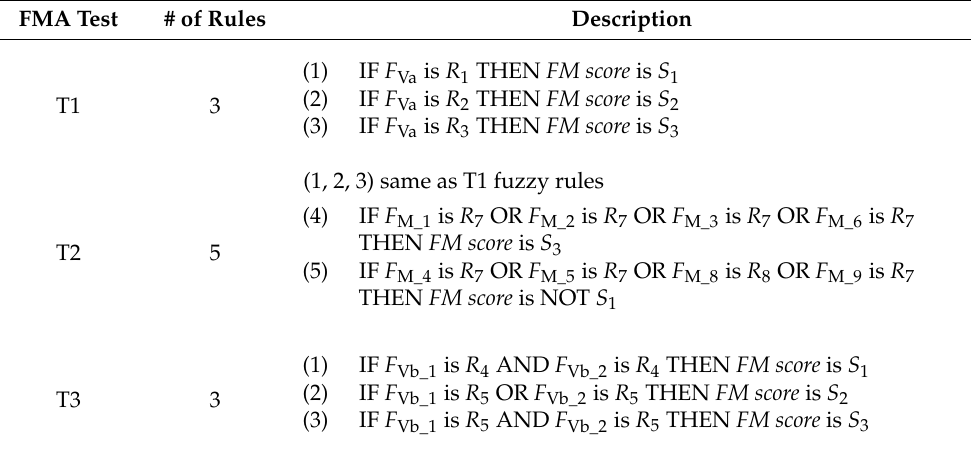
Table 4. Fuzzy rules of each target FMA test. FMA